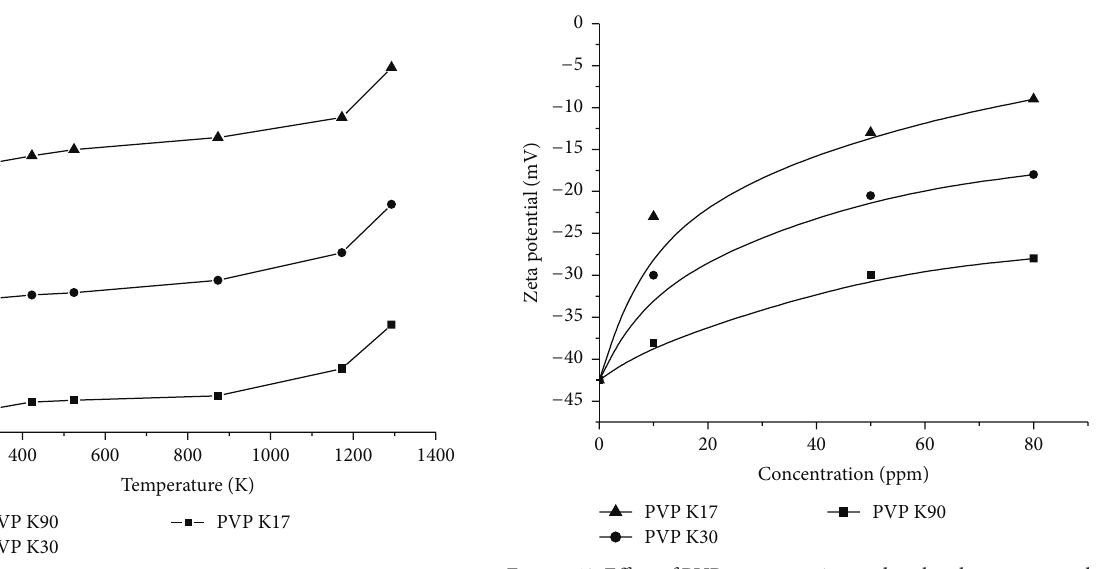
Figure 11: Effect of pretreatment of AEROSIL OX 50 on adsorption of PVP. The reported data are our own and the one reported by Cohen Stuart et al. [39].